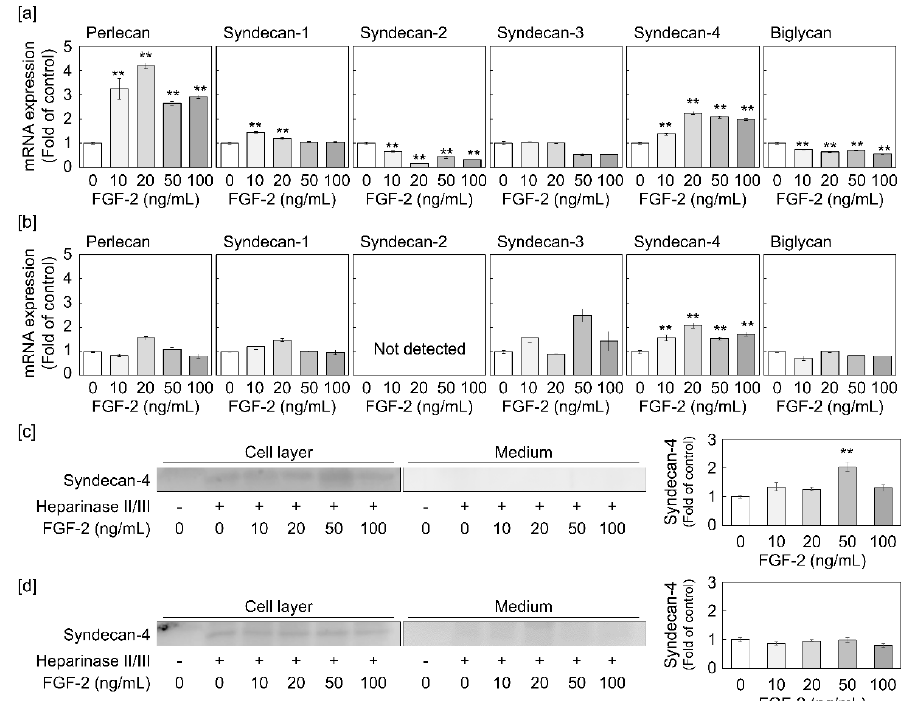
Figure 1. Dose-dependent effects of fibroblast growth factor-2 (FGF-2) on proteoglycan expression in dense and sparse cultures of vascular endothelial cells. The cells were incubated with or without FGF-2 at 10, 20, 50, and 100 ng/mL at 37 °C for 8 h. The mRNA level of the indicated proteoglycans in dense ( a ) and sparse ( b ) cultures of vascular endothelial cells was assessed by qRT-PCR. Values represent the mean ± S.E. of four technical replicates. ** p < 0.01, significantly different from the corresponding control (0 ng/mL of FGF-2). The syndecan-4 core protein expression in the vascular endothelial cell layer and conditioned medium from dense ( c ) and sparse ( d ) cultures of vascular endothelial cells was analyzed by western blotting. The bar graphs show the intensity of syndecan-4 in the cell layer in the group treated with heparinase II/III. The values in the bar graphs indicate the means ± S.E. of three samples of the experiments. **Significantly different from the control, p < 0.01.